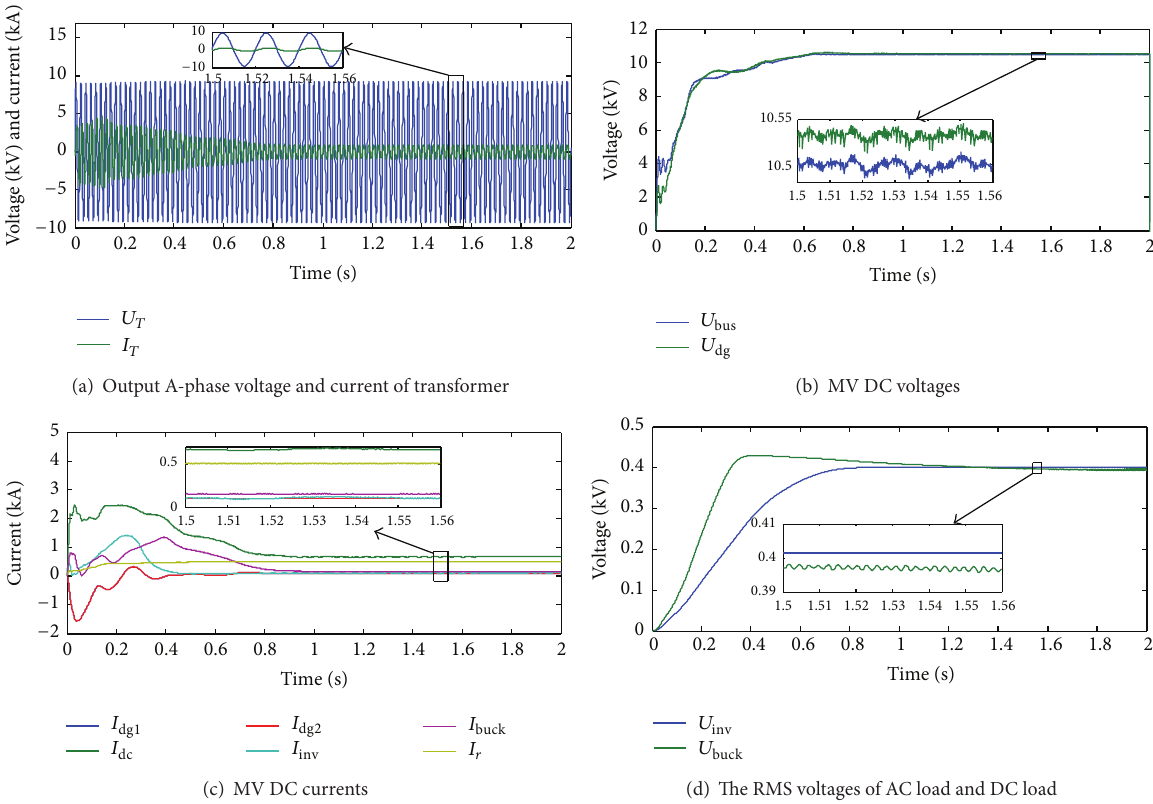
Figure 3: The step response